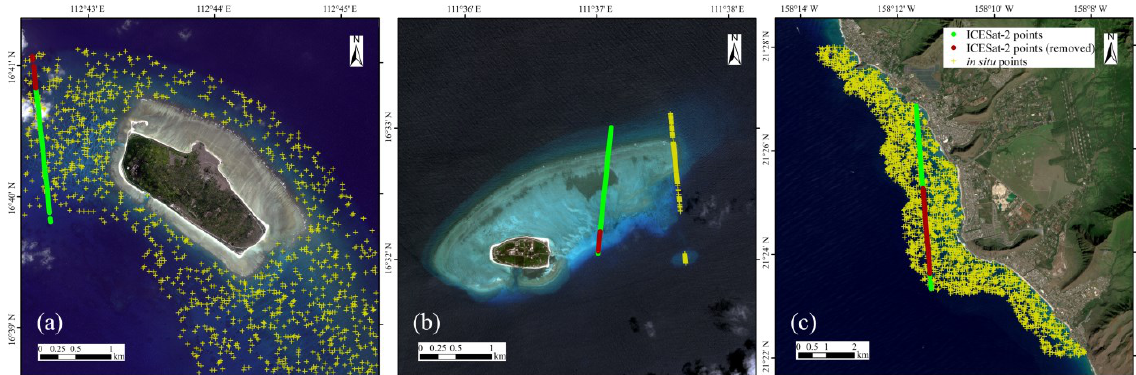
Figure 2. The three study areas and the data used in this paper: ( a ) Study area A is the sea area near Dongdao Island, Xisha Islands, China. ( b ) Study area B is the sea area near Shanhu Island, Xisha Islands, China. ( c ) Study area C is the west coast of Oahu Island, Hawaii. Among them, the green and red points represent the ICESat-2 bathymetry data used in the experiment, where the red part is manually removed to simulate the scene of missing ICESat-2 bathymetric signals, and the yellow “ + ” represents the validation data used in the experiment.